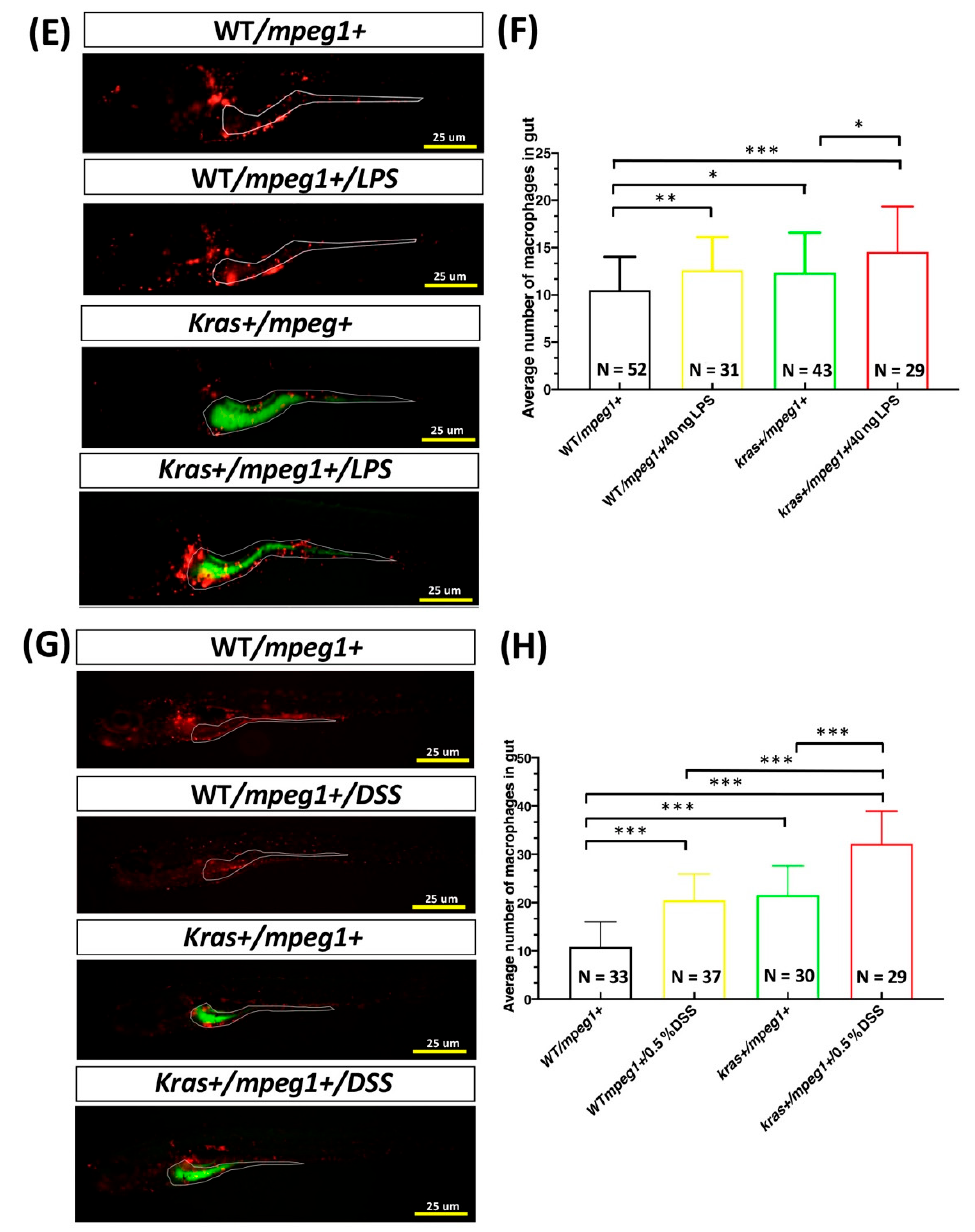
Figure 1. DSS or LPS enhances the increase in intestinal neutrophils and macrophages in kras+/lyz+ and kras+/mepg1+ zebrafish larvae. ( A , C , E,G ) Fluorescence of neutrophils and macrophages in the intestine. ( B , D , F , H ) Quantification of the number of positive cells as revealed by fluorescence of neutrophils or macrophages. Differences among the variables were assessed using Student’s t-tests. Statistical significance: * p < 0.05, ** p < 0.01, *** p < 0.001. Scale bar: 25 μ m.